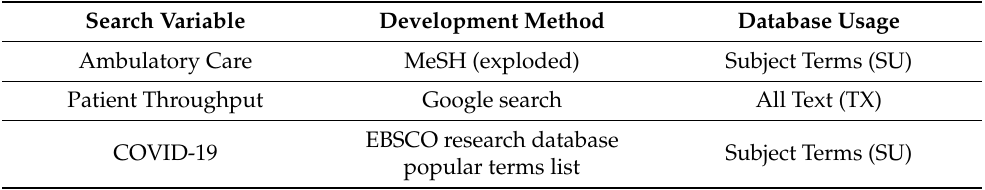
Table 1. Development and Use of Search